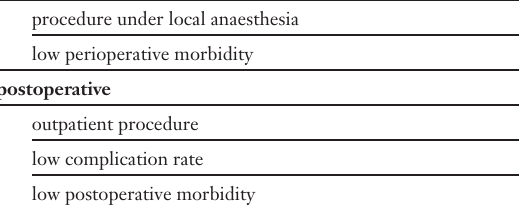
Criteria for minimally invasive surgery.